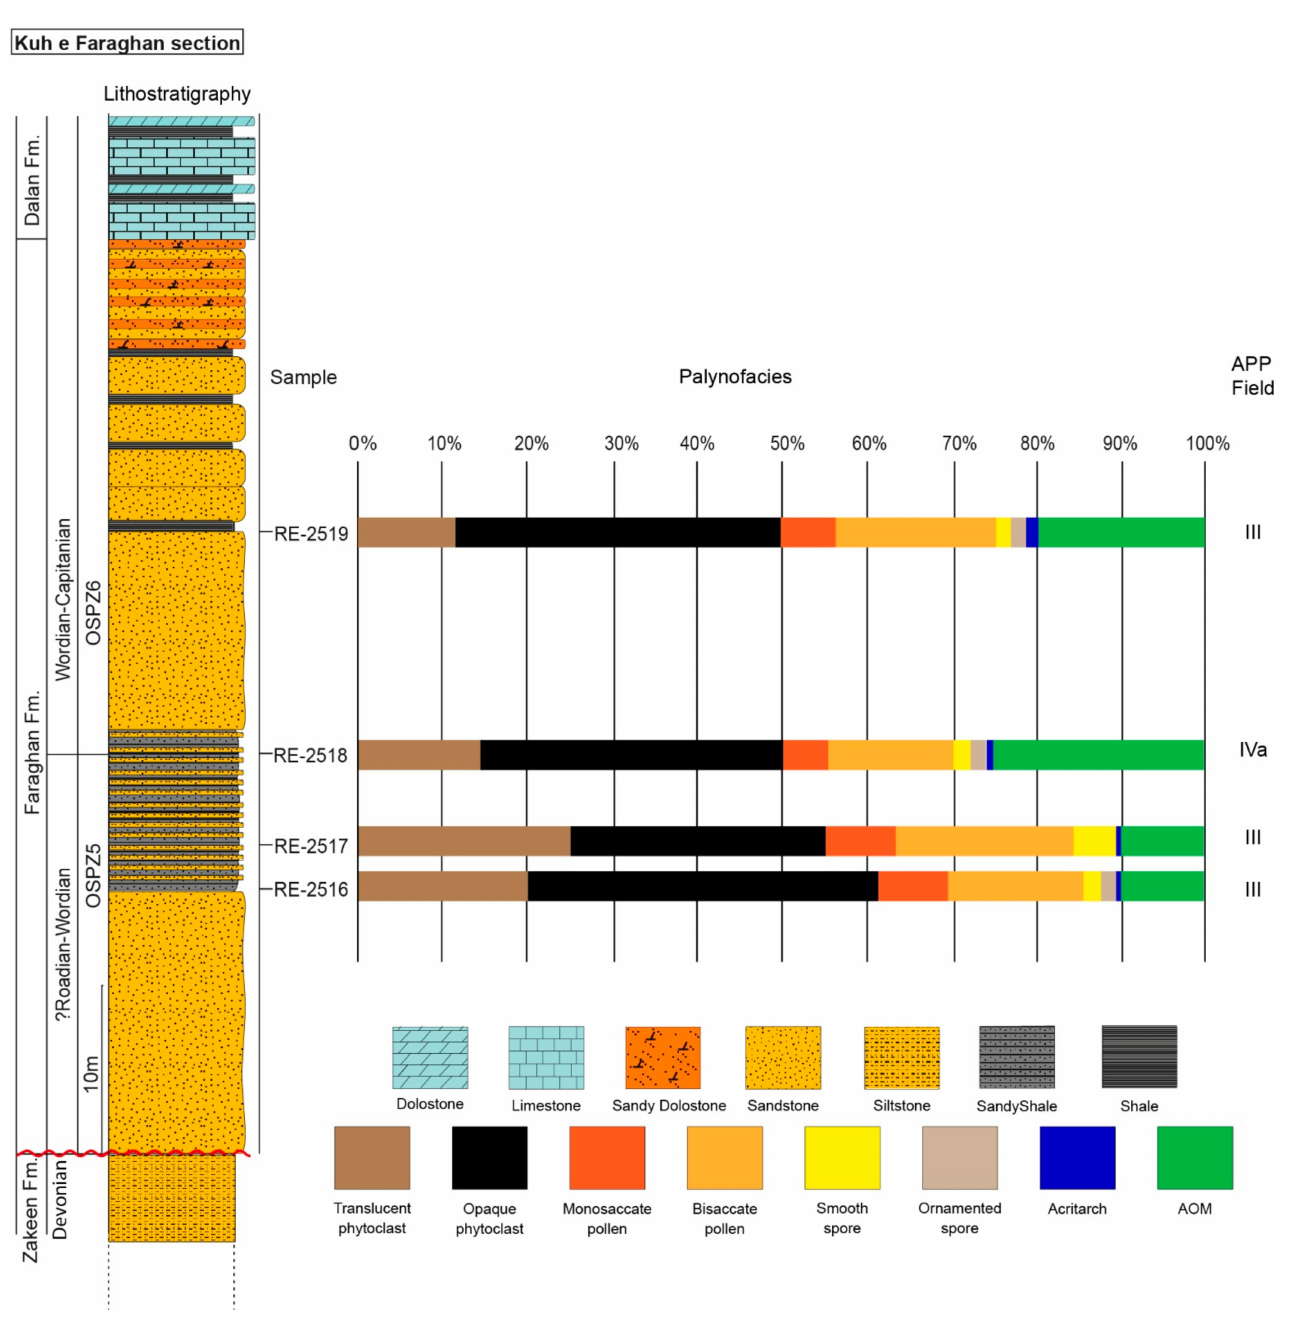
Figure 3. Stratigraphic log sampled horizons and palynofacies of the Faraghan Formation at the Kuh e Faraghan section. Spina et al. [21] attributed the lower to middle portion of the formation to the Roadian- Wordian (OSPZ5 biozone) and the upper part to Wordian-Capitanian (OSPZ6 Biozone; Figure